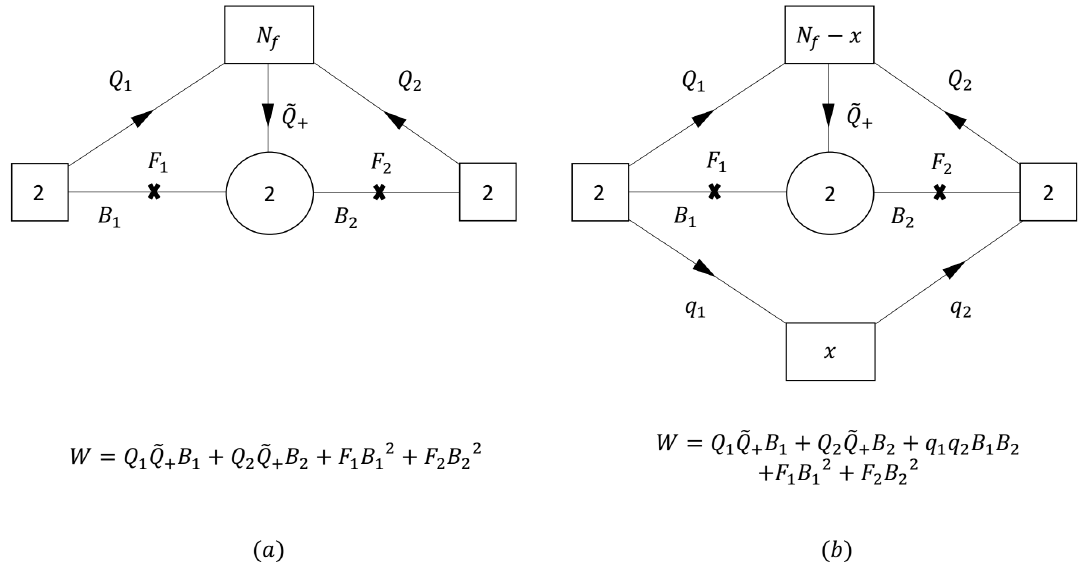
Figure 2 . The conjectured 3 d theory associated with the compactification of the rank 1 5 d E N SCFT on a tube with two maximal punctures for various values of flux. Here we use the same conventions for denoting quiver theories, with the addition of using circles to denote gauge groups, again as customary. The case in (a) comes from gluing the basic tube in figure 1 to itself, while the case in (b) comes from gluing it to an equivalent one made by acting on it with a specific Weyl group element. Like in the previous case, W denotes the superpotentials, with the last terms being the flipping